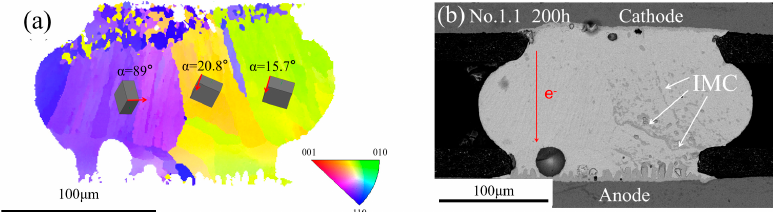
Figure 6. ( a ) EBSD map of the No.2 solder joint after reflow; ( b ) SEM image of the No.2 solder joint after current stressing for 200 h.